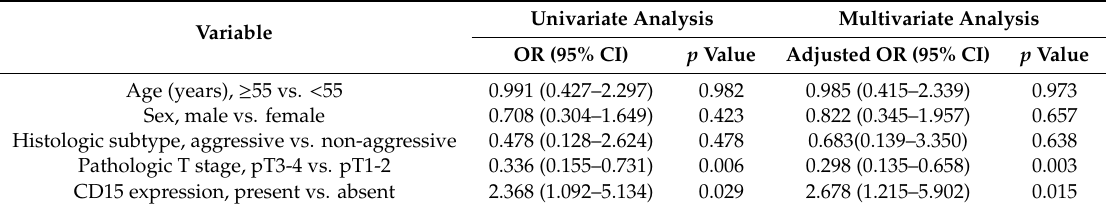
Table 3. Univariate and multivariate logistic regression analyses of clinicopathological variables associated with long-term excellent therapeutic response in 467 patients with papillary thyroid carcinoma treated with total thyroidectomy and radioiodine remnant